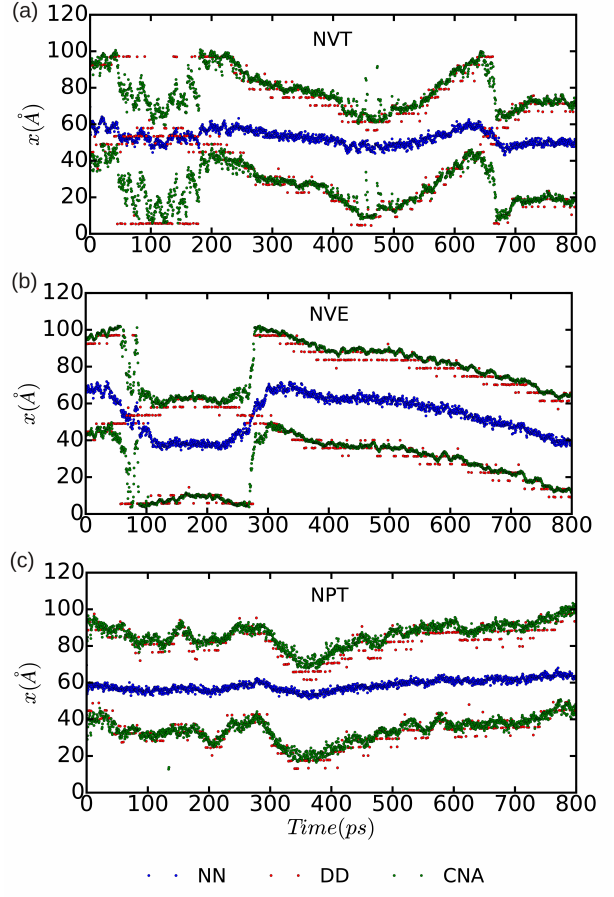
Figure 11. Position of the edge dissociated dislocation expressed as a function of time for a simulation cell containing N = 18424 atoms. Molecular dynamics simulations have been performed in the three thermodynamic ensembles ( a ) NVT , ( b ) NVE , and ( c ) NPT ; the temperature has been fixed to 50 K, the pressure to zero, and the volume to the equilibrium one. In the NVE case, an equilibrium temperature of 25 K is reached. “DD”, “NN”, and “CNA” stand for the analysis methods of differential displacement, nearest neighbors, and common neighbor,